Question: Write a caption explaining this figure to a reader.
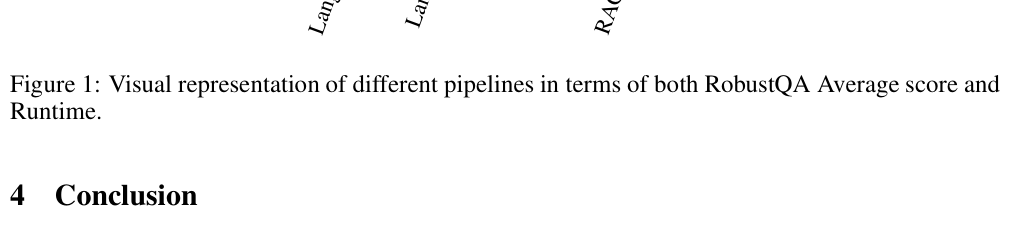
Answer: Visual representation of different pipelines in terms of both RobustQA Average score and Runtime.